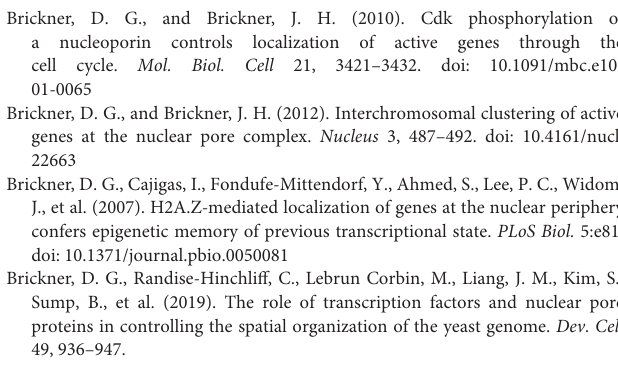
FIGURE S1 | Sumoylation of proteins at the uninduced INO1 locus. (A) Diagram of the INO1 locus and regions detected by ChIP analysis (see Figure 1A ). (B,C) The graphs show the relative fold enrichment of SUMO modified proteins at each position along the INO1 gene relative to the level of SUMO modified proteins at an intergenic region within chromosome V as assessed by ChIP. B shows ChIP results for uninduced WT samples while C shows results comparing uninduced WT samples (WT 0 h) to samples derived from siz2 (cid:49) cells at the indicated times after INO1 induction. Results are the means ± SEM of at least three biological replicates. FIGURE S2 | Siz2 associates with the GRS1 region of the uninduced INO1 locus. (A) Diagram of the INO1 locus and regions detected by ChIP analysis (see Figure 1A ). The graph shows the relative fold enrichment of Siz2-PrA (B) or Ulp1-PrA (C) at each position along the INO1 gene relative to the level at an intergenic region within chromosome V as assessed by ChIP. Results are the means ± SEM of at least three biological replicates. FIGURE S3 | Characterization of chromosomally encoded ulp1 truncation mutants. (A) Shown are cells producing Ulp1-GFP or the indicated truncation mutants (ulp1 (cid:49) 1 − 150 -GFP, ulp1 (cid:49) 150 − 340 -GFP, and ulp1 (cid:49) 1 − 340 -GFP) encoded by integrated and ULP1 promoter-controlled mutant genes. Camera exposure times are equivalent for each strain. Scale bars = 2 µ m. (B) Truncation mutants showed similar expression levels with that of full length Ulp1-GFP. Whole cell lysates of the indicated strains were tested by Western blotting with an anti-GFP antibody. For the loading control, the levels of Gsp1 were tested with an anti-Gsp1p antibody. (C) Whole cell lysates, derived from cultures of the indicated strains, were examined by Western blotting using an anti-Smt3 (SUMO) or an anti-Gsp1 (loading control) antibody. The positions of molecular mass markers are indicated in kilodaltons. FIGURE S4 | Growth of strains producing ulp1 CSDN and Nup53-ulp1 341 − 621 . (A) WT cells transformed with an empty plasmid (pEMPTY), a plasmid encoding WT Ulp1 (p ULP1 ), or a plasmid encoding the ulp1 CSDN mutant (p ulp1 CSDN ) were grown to mid-log phase in synthetic drop out liquid culture. Tenfold serial dilutions of each culture were made and cells from each dilution spotted onto synthetic drop out plates. Total cells plated ranged between 10 5 and 10 2 cells per spot. Plates were then incubated at 30 ◦ C for 2 days prior to imaging. (B) Cell lysates, derived from the same cultures described in A , were examined by Western blotting using an anti-Smt3 (SUMO) or an anti-Gsp1 (loading control) antibody. The positions of molecular mass markers are indicated in kilodaltons. (C) WT